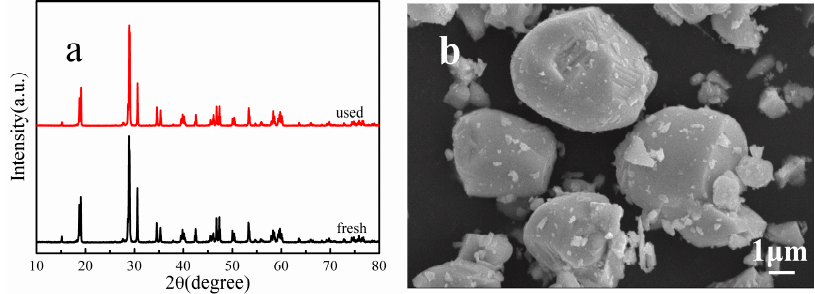
Figure 9. ( a ) XRD patterns and ( b ) SEM micrograph of sample H700 before and after the photo-stability tests.